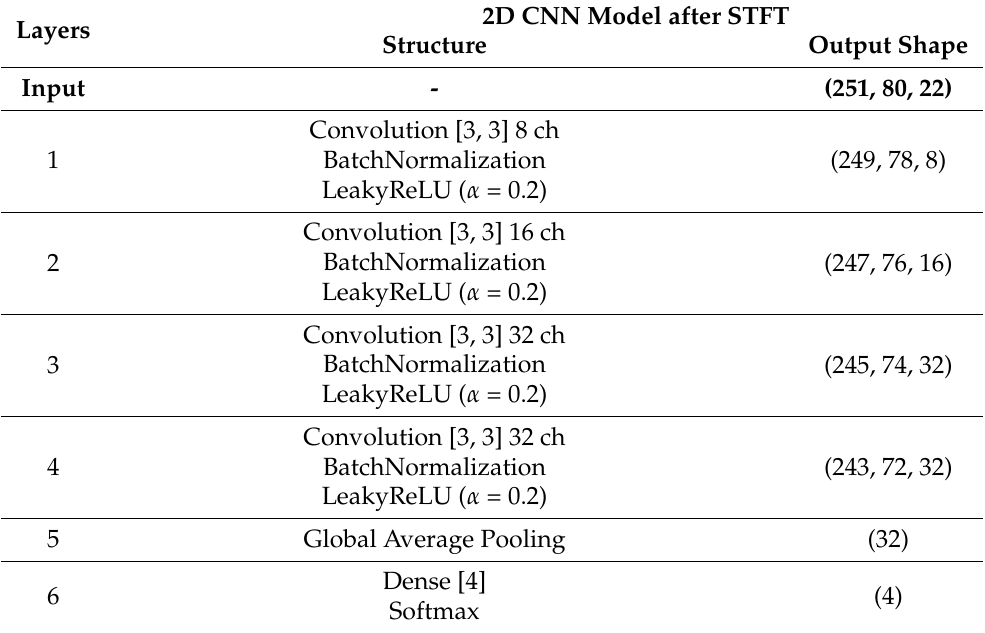
Table 4. The model structure 2D CNN after